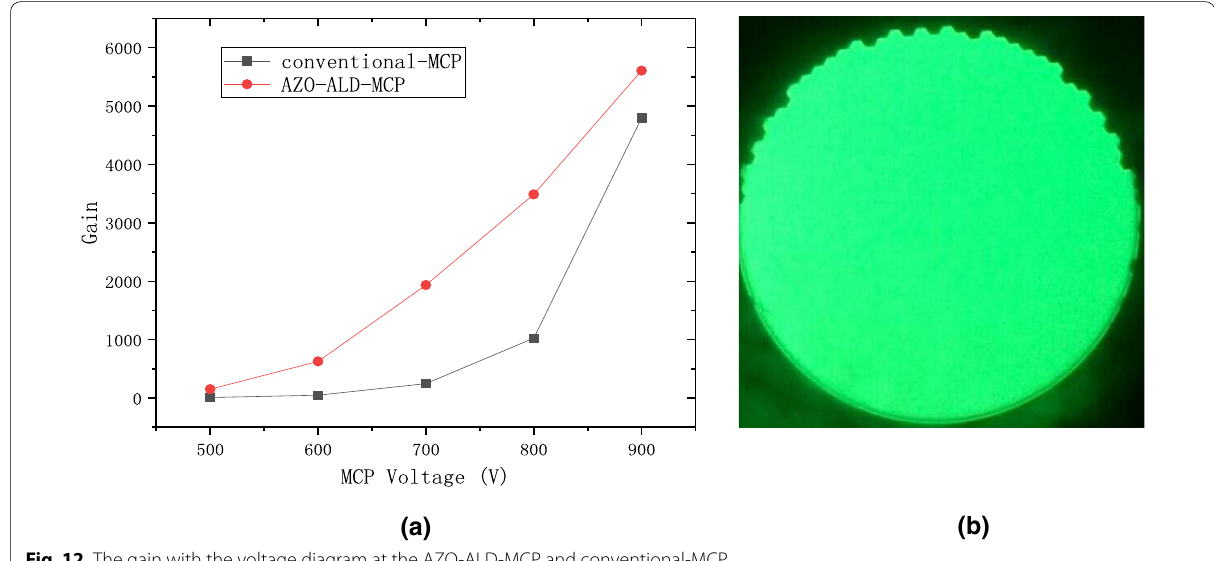
Fig. 12 The gain with the voltage diagram at the AZO-ALD-MCP and